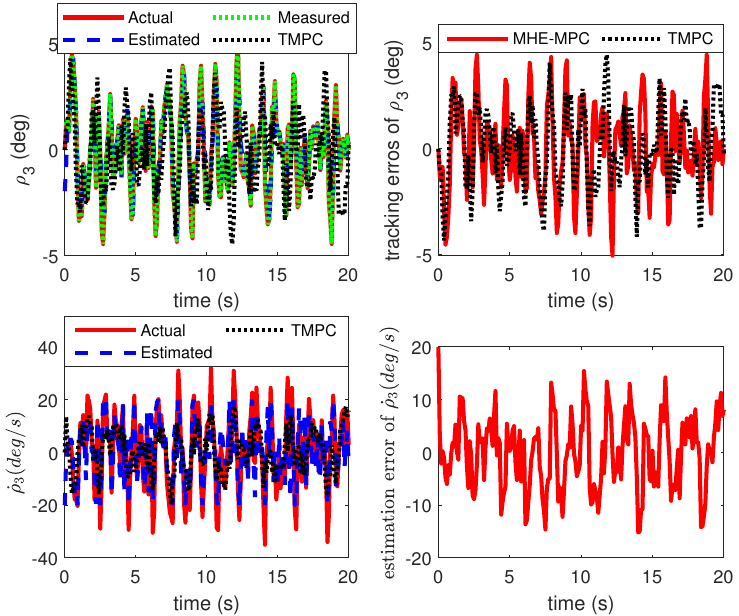
Figure 10. Case 2: state variables ρ 3 , ˙ ρ 3 and their tracking/estimation